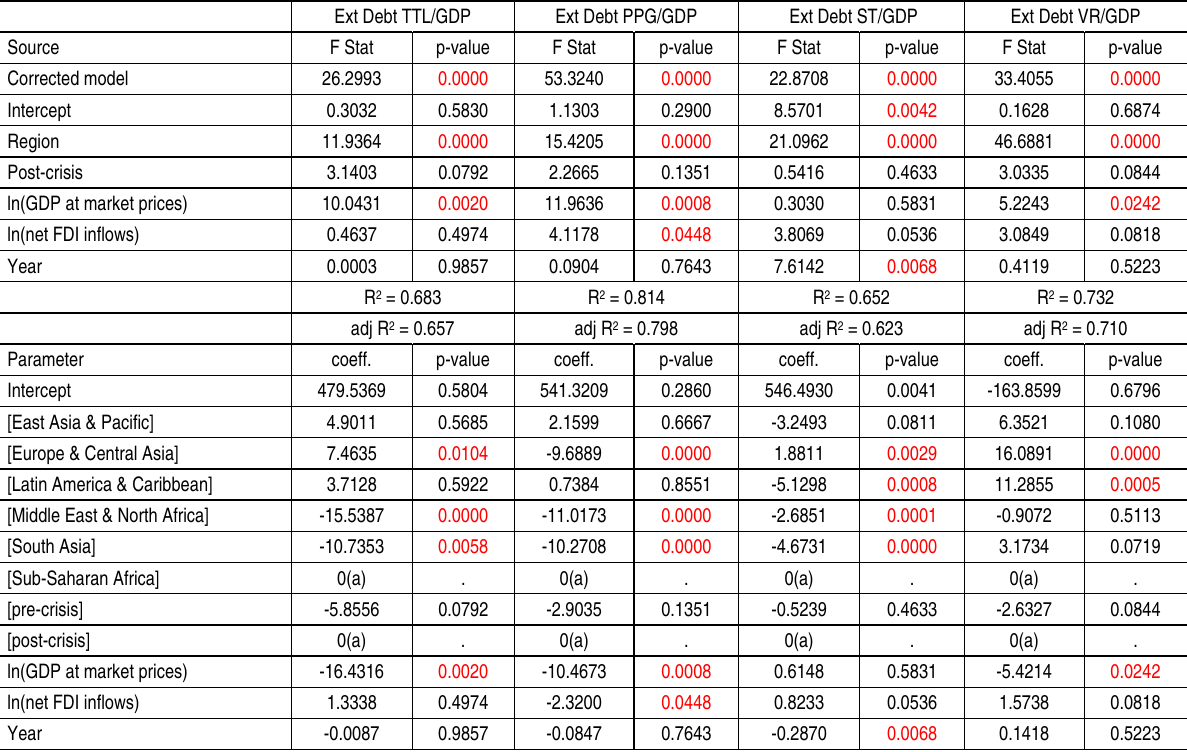
Table 12. Fixed effects panel regression for total external debt, PPG external debt, ST external debt, and